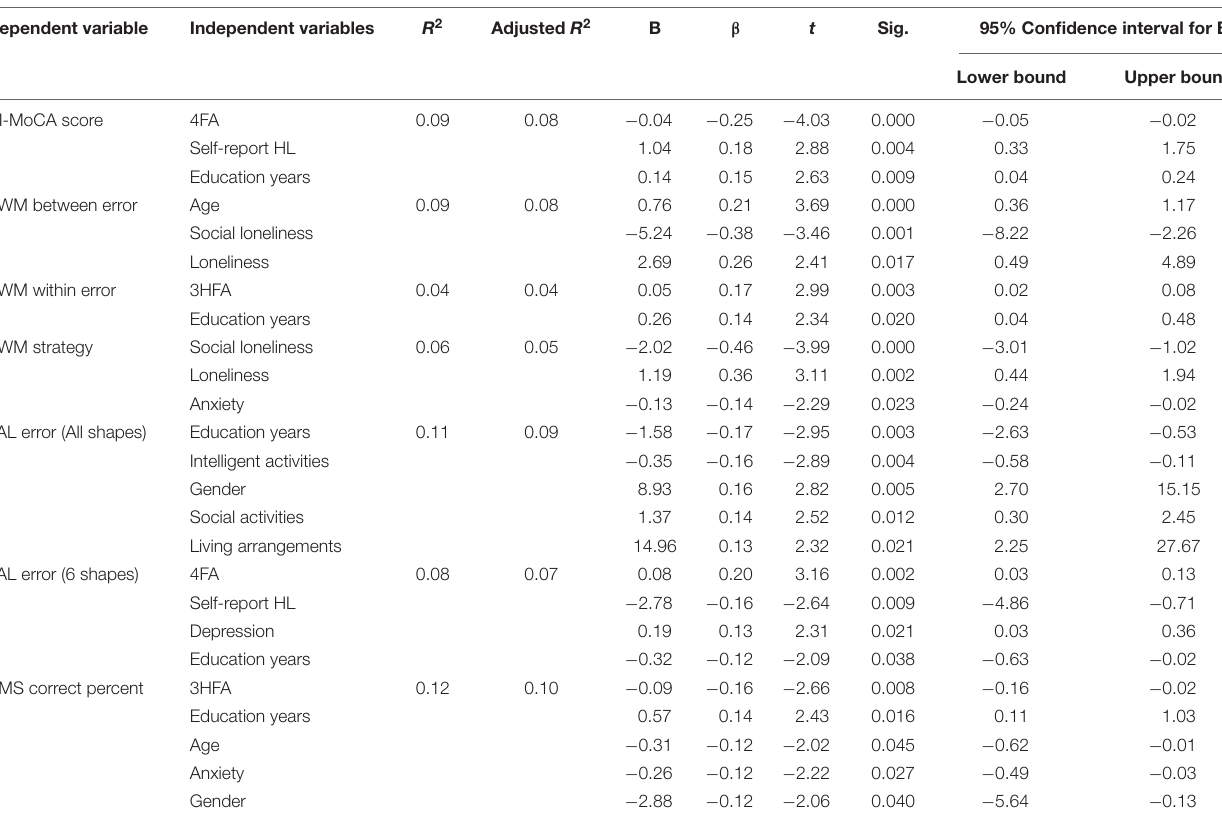
TABLE 2 | Multiple stepwise regression between CANTAB/HI-MoCA scores and other variables. Dependent